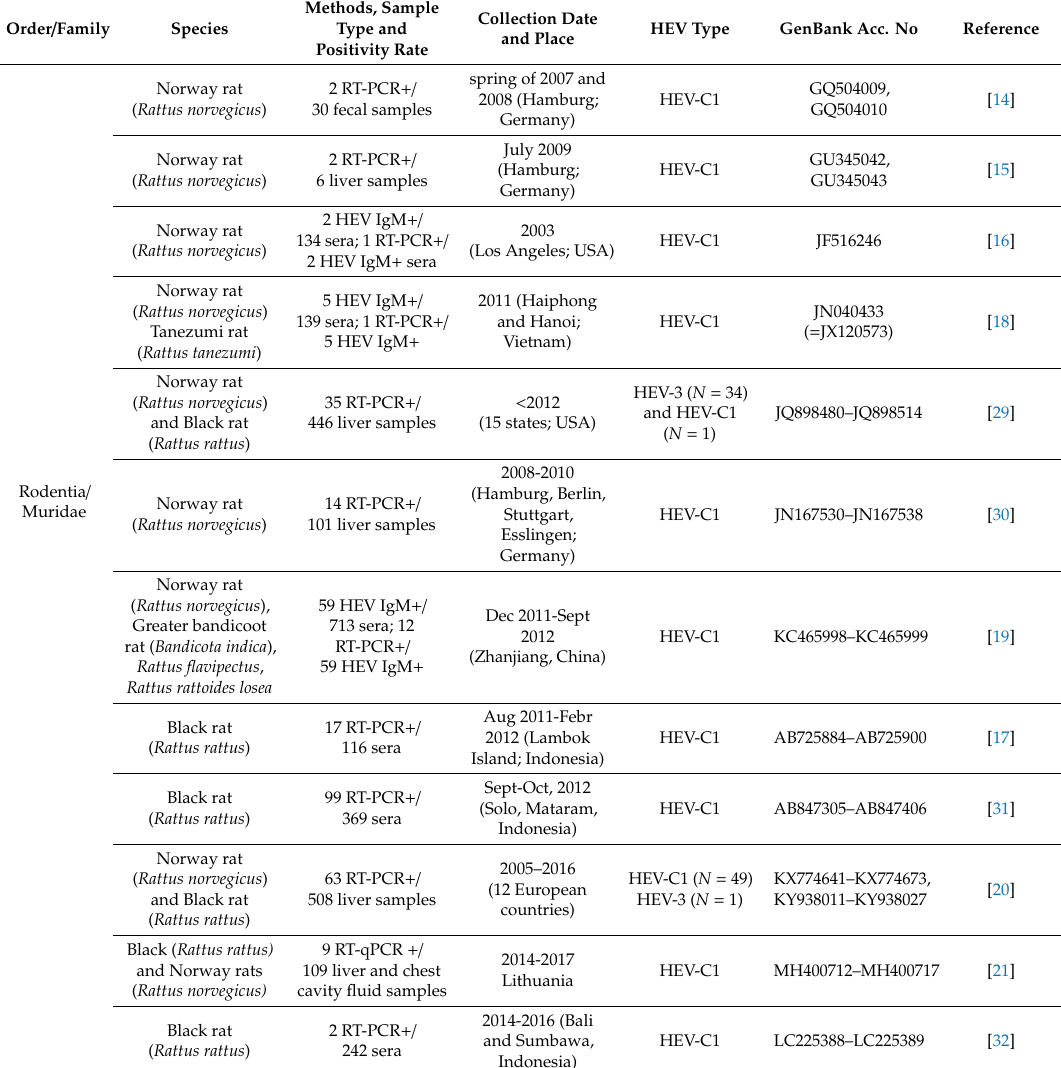
Table 2. Summary of rat hepevirus (hepatitis E virus (HEV)-C1) molecular studies in the literature. Order /